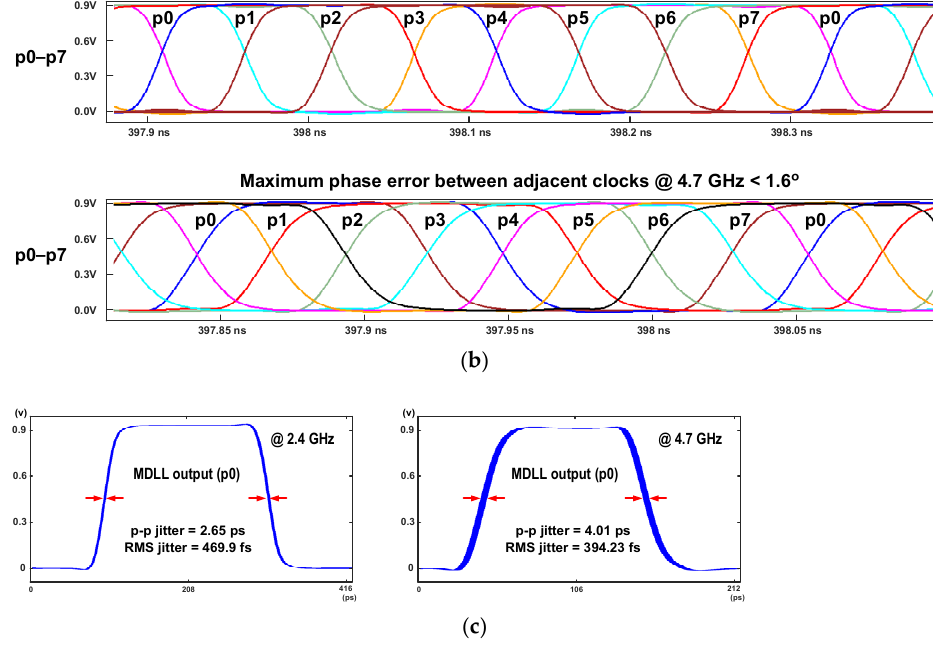
Figure 5. ( a ) Proposed low-jitter eight-phase all-digital MDLL, ( b ) eight-phase output clocks of the MDLL, and ( c ) post-layout-based jitter simulation performance of the proposed all-digital